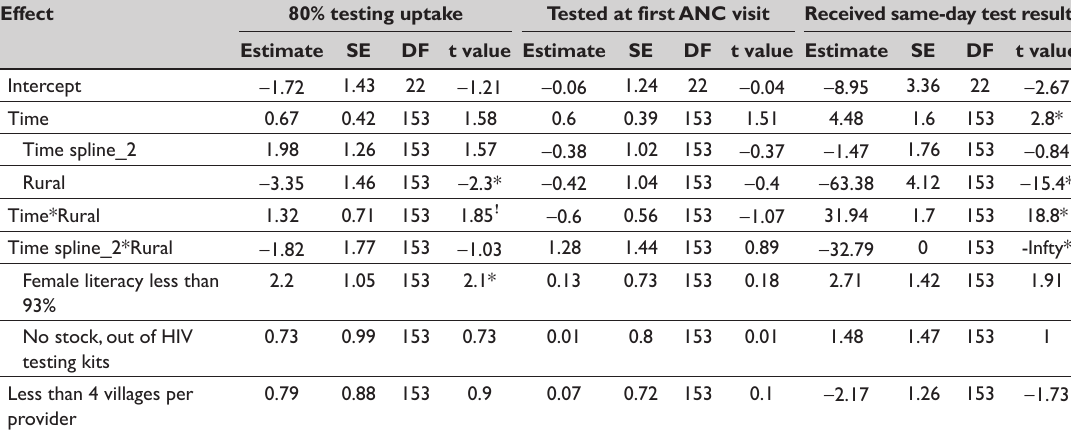
Table 2: Adjusted random effects logistic models on log odds of achieving 80% testing uptake among pregnant women attending ANC, 80% ANC attendees being tested for HIV at first visit, and